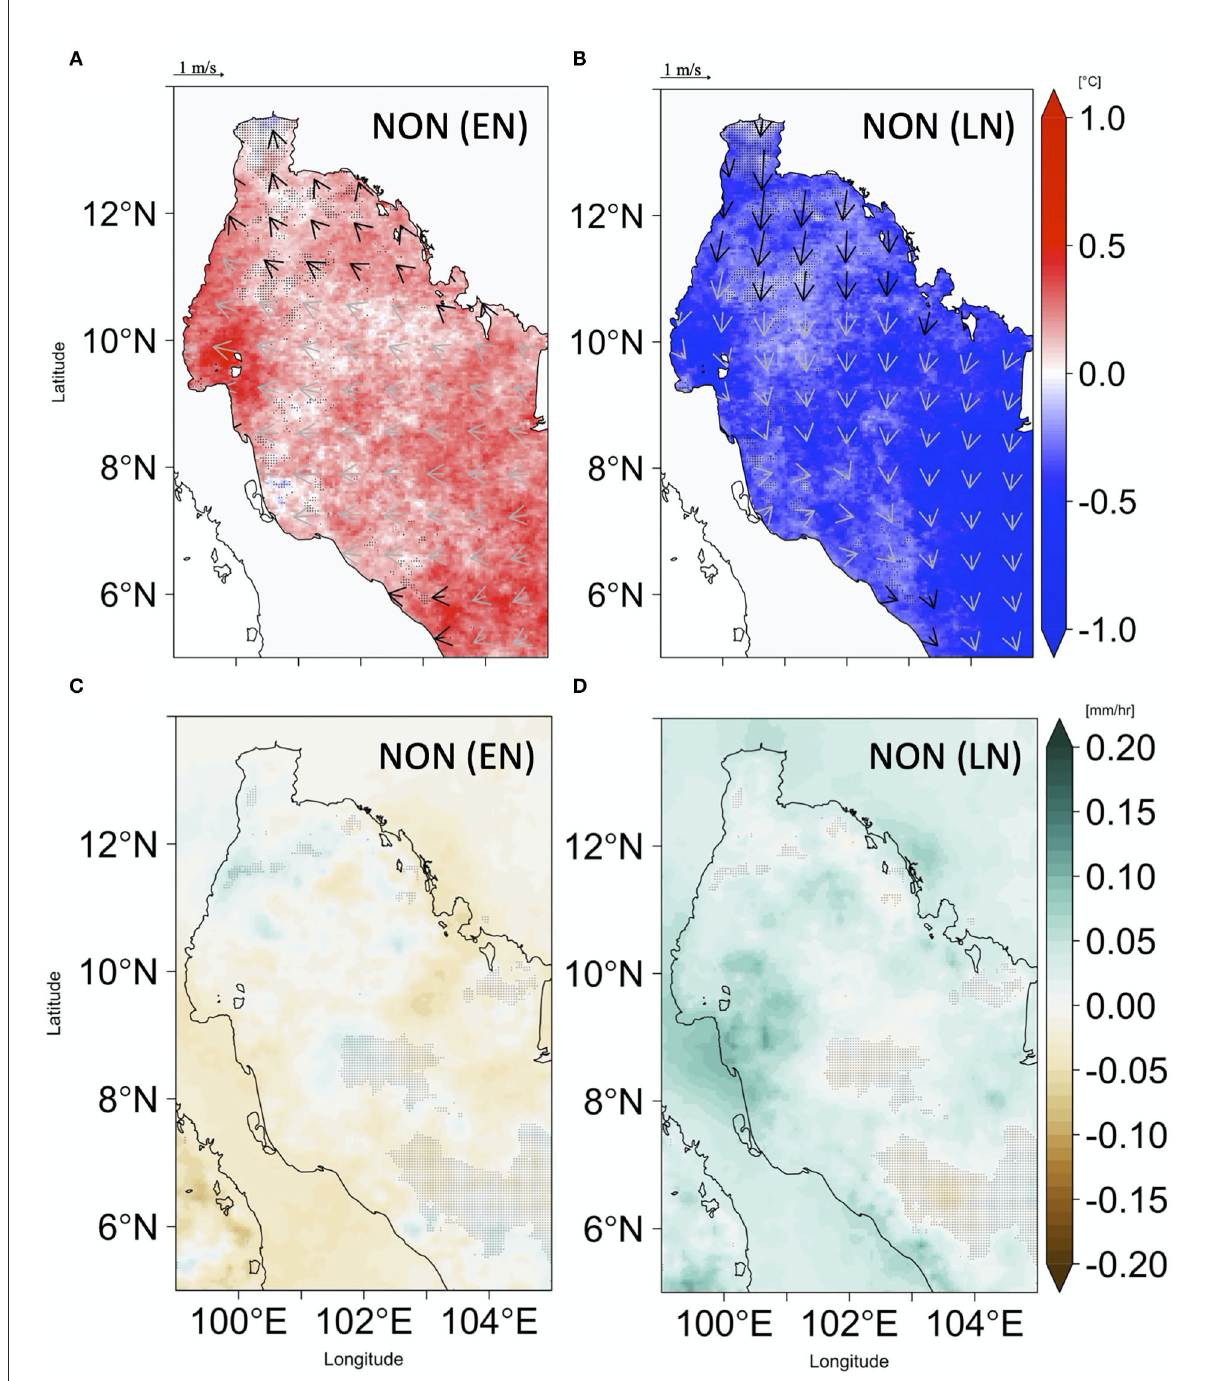
FIGURE9 SST and wind anomalies under EN (A) and LN (B) with precipitation anomaly under EN (C) and LN (D) during NON. The gray vectors and dots indicate the non-significant level ( p > 0.05) of correlation between the parameter and MEI.